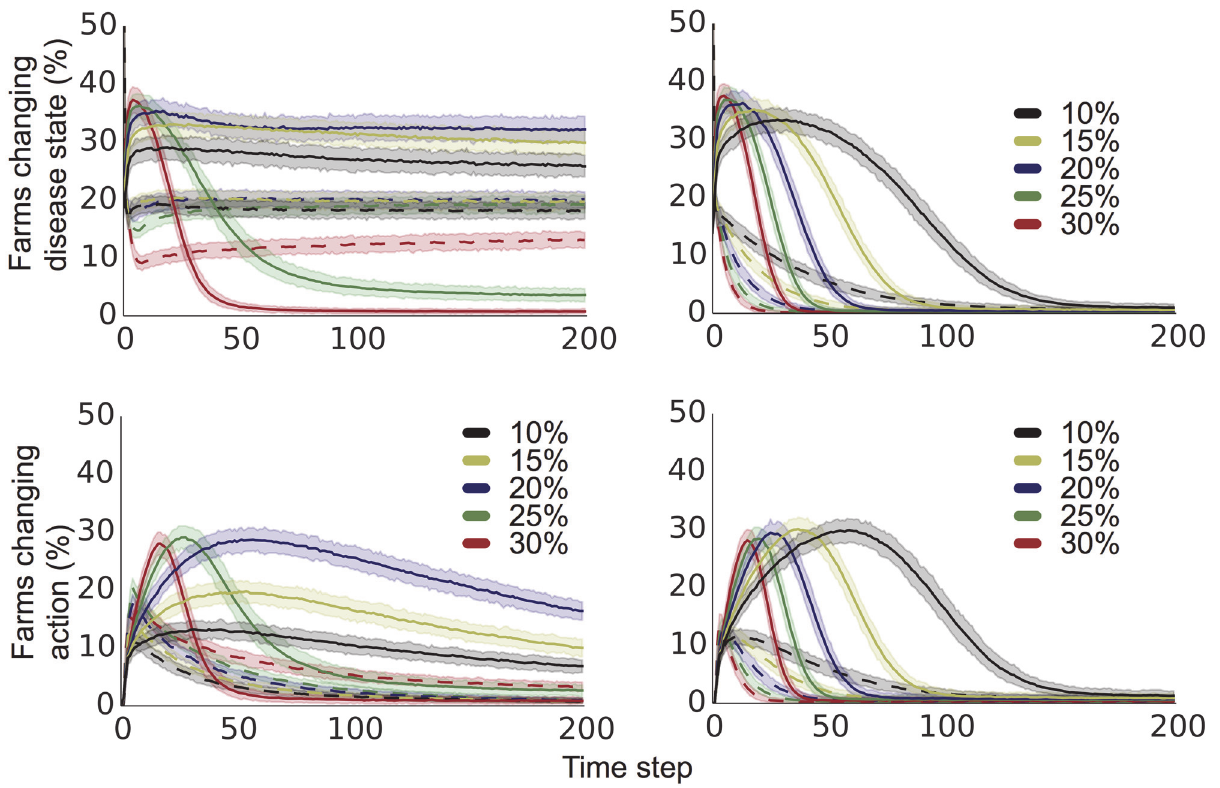
Fig 2. Percentages of farms changing disease and action state over the length of the simulation at differing probabilities of bringing-in the disease with the riskier action, and two distributions of payoffs. In the left column we show results from simulations of idealist farms which compare their payoffs to a set general payoff estimate, and on the right results from simulations of realist farms that compare only to payoffs they have experienced. 95% confidence envelopes are plotted in pale shading around each line.